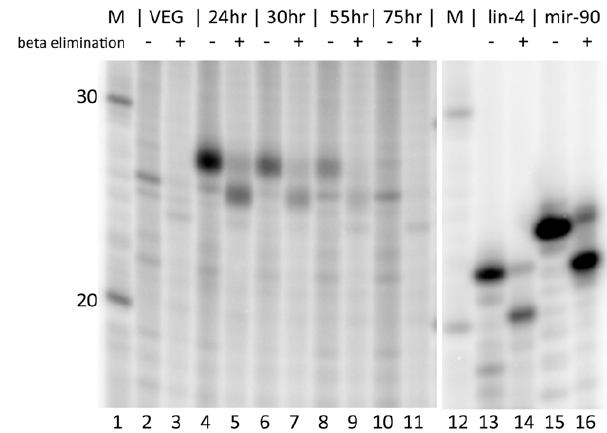
Figure 2. The mating-specific 27 nt RNAs in Oxytrichatrifallax are not modified at their 3 9 ends. RNAs were tested with the beta elimination assay in order to determine if there is a modification at the 3 9 end. RNAs tested are 32 P 5 9 end labeled total Oxytricha trifallax RNA (lanes 2–11) or 5 9 end labeled synthetic positive control RNAs containing the sequence of the C. elegans lin-4 (21 nt) or mir-90 (23 nt) microRNAs which were subsequently mixed with 1.5 m g of unlabeled Oxytricha total RNA prior to beta elimination (lanes 13–16). Control untreated samples (-) or samples subjected to the beta elimination reaction ( + ) are indicated. RNAs were isolated from vegetative ALXC2 (lanes 2 and 3) or from a mating between ALXC2 and ALXC9 that were harvested at the indicated timepoint after mixing (lanes 4–11). Beta elimination will remove the terminal ribose if both a free 2 9 OH and 3 9 OH are present, and will leave a 3 9 cyclic phosphate. This loss of a nucleotide and the presence of the extra phosphate group will result in the treated RNAs running almost two bases faster than their untreated counterparts.